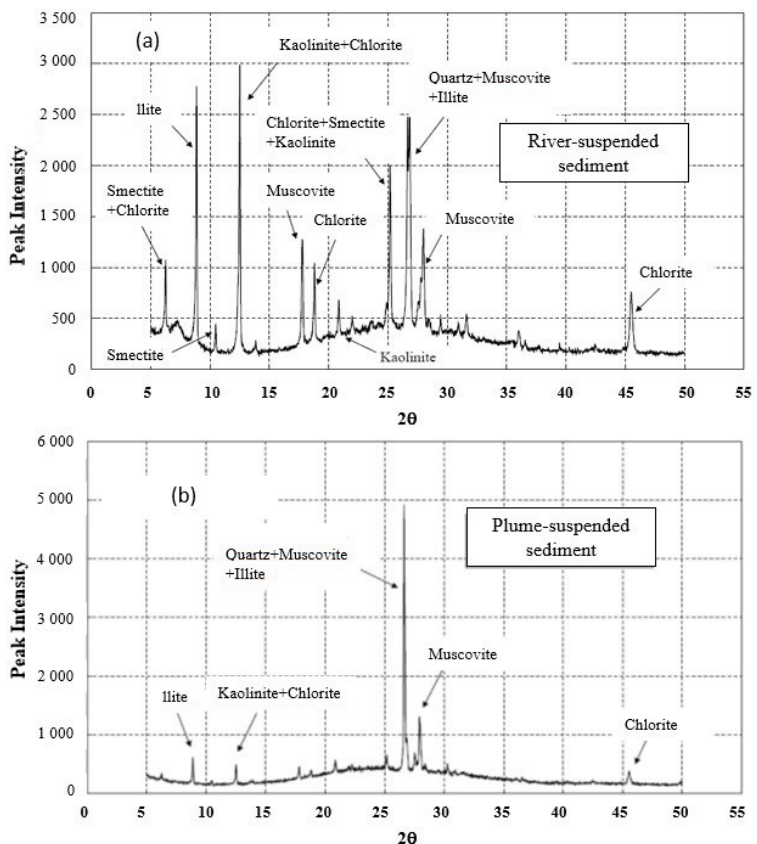
Figure 9. Mineralogy of suspended sediment at grain size d ≤ 4 μ m by the X-ray diffraction method. The sediments were sampled at ( a ) site PLS and ( b ) site B9 in September 2009. θ : Bragg angle (°)